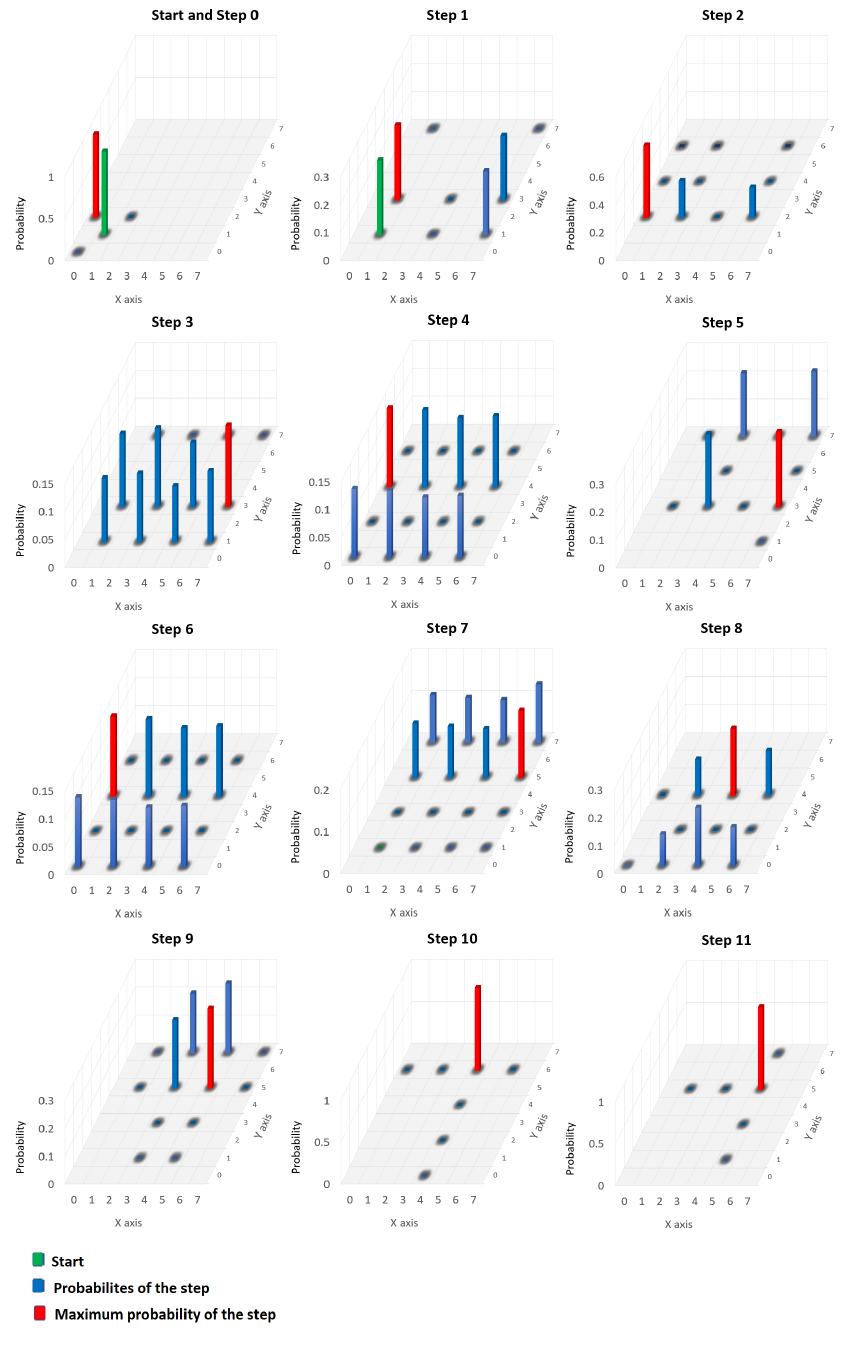
Figure 20. The representation of the probabilities of the best individual for HCQGA. The evolution of the solution search is given in Table